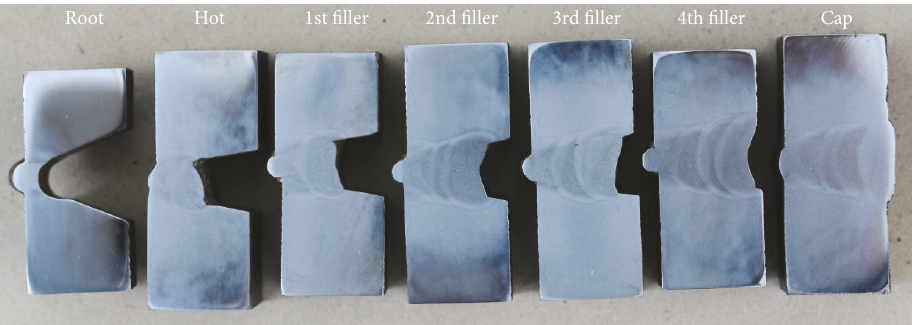
Figure 4: Macrograph of welding species of the combined girth-welded joint with 7 layers